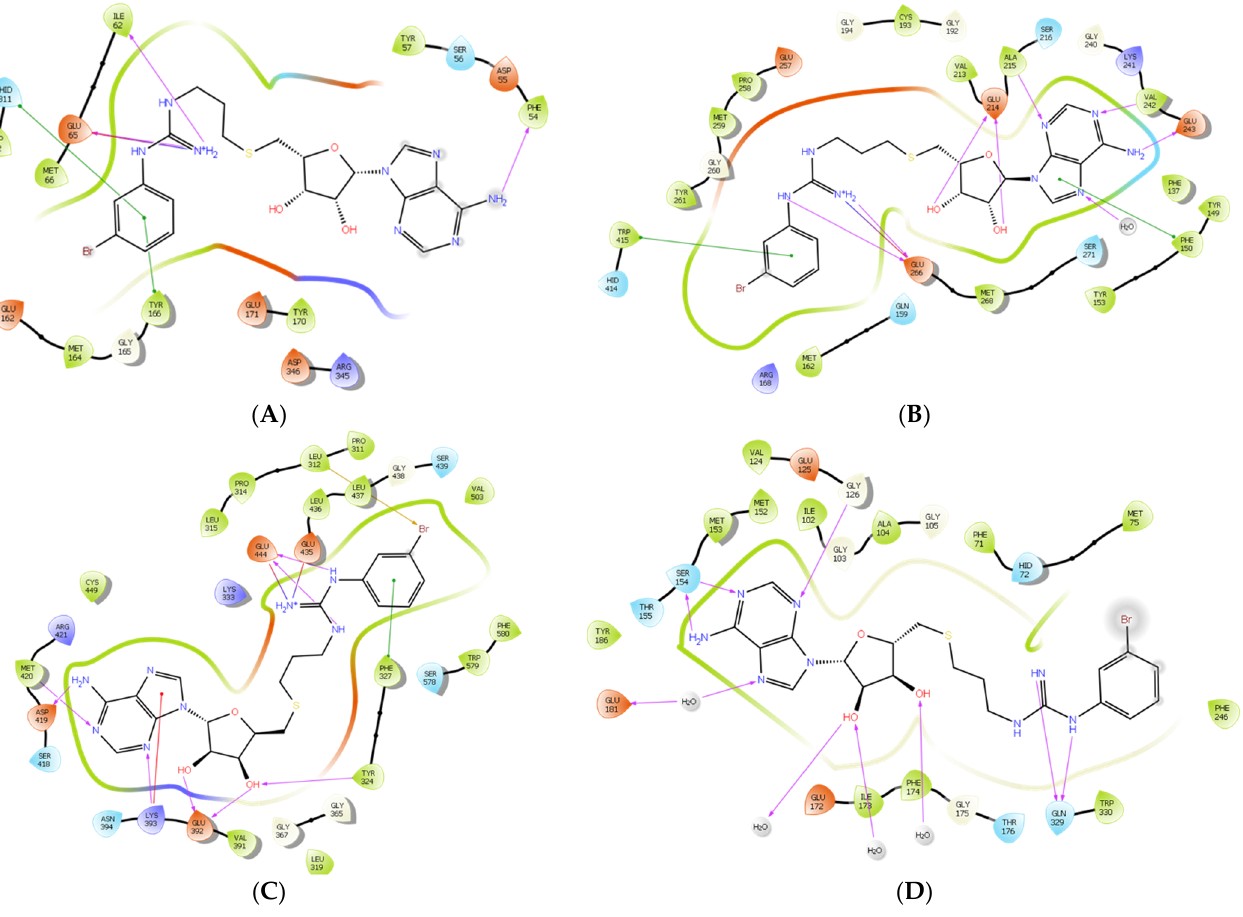
Figure 8. The predicted 2D interactions of II757 inside the active site of ( A ) PRMT1 (pdb: 6nt2), ( B ) PRMT4 (pdb: 6s79), ( C ) PRMT5 (pdb: 6ckc), and ( D ) PRMT7 (pdb: 4m37). II757 is shown in the black line model.